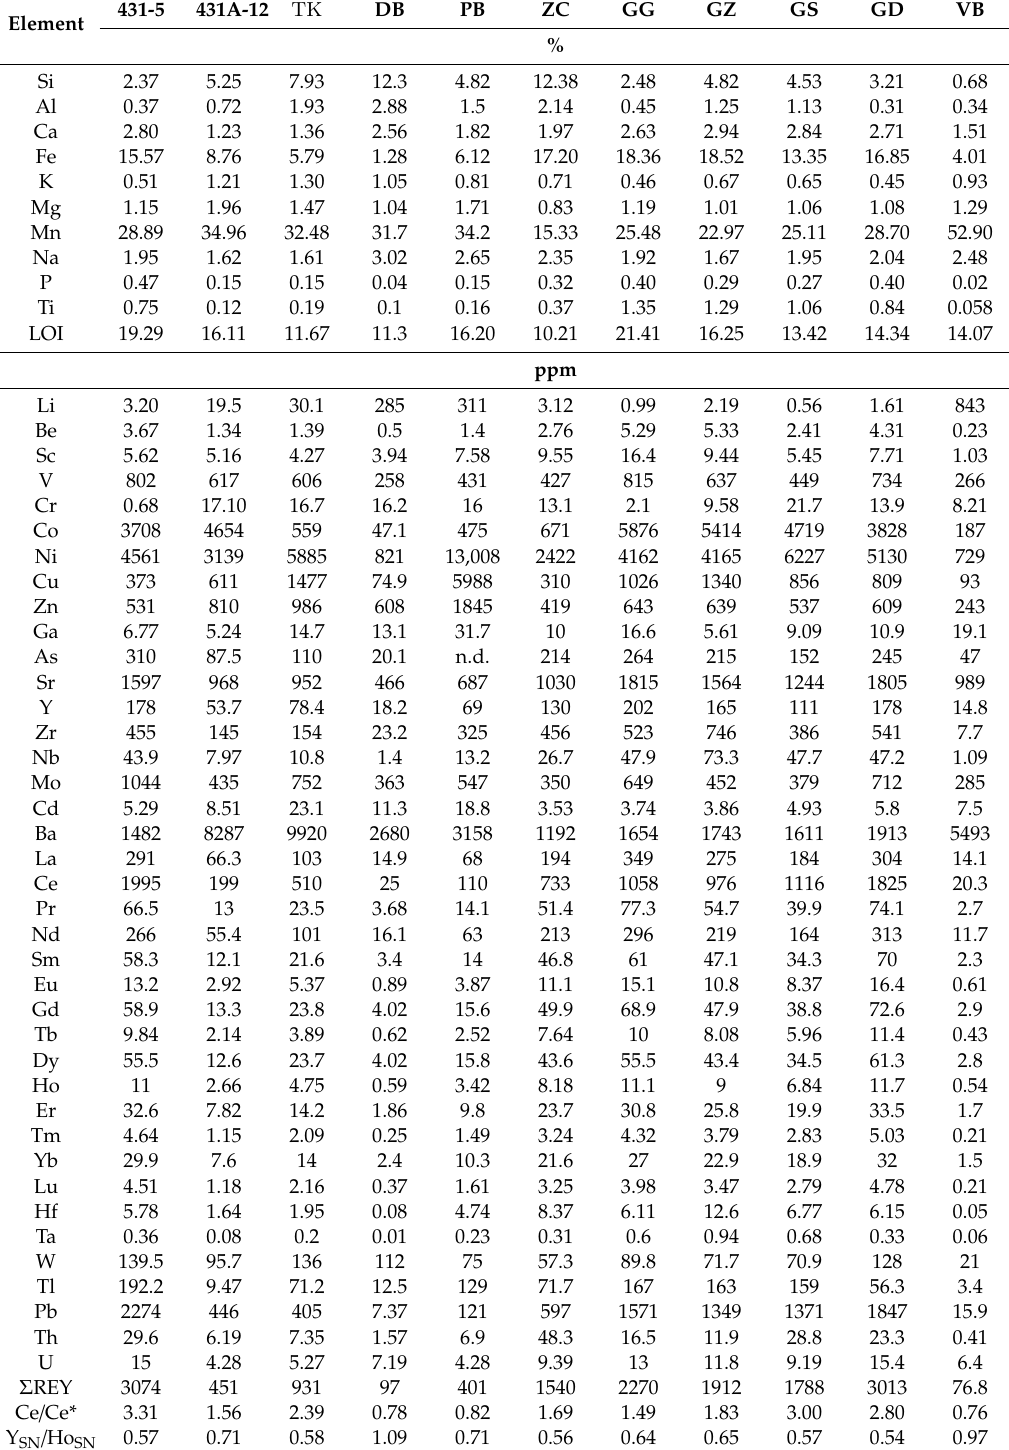
Table 3. Bulk chemical composition of the samples 431-5 и 431A-12 compare with Fe-Mn deposits from di ff erent geological